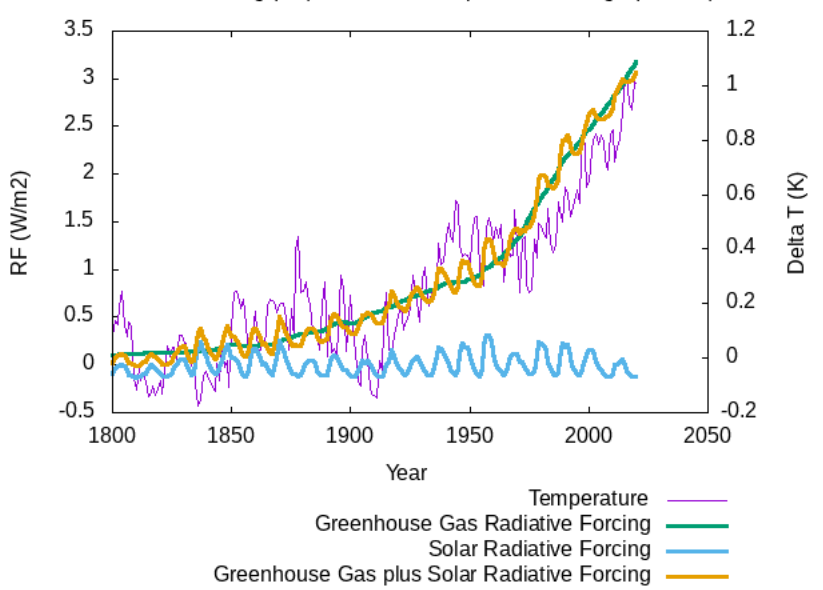
Figure 7. Purple curve, right scale: global temperature change. Green curve, left scale: greenhouse gas radiative forcing. Blue curve, left scale: solar radiative forcing. Ochre curve, left scale: combined greenhouse gas and solar radiative